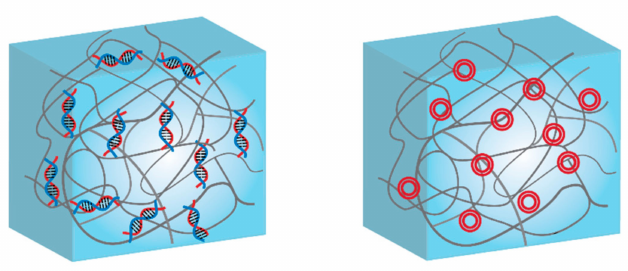
Scheme 3. Schematics of DNA-functionalized hybrid hydrogels: (left) single-stranded DNA covalently attached to the polymer sca ff old, and (right) plasmids or long DNA sequences conjugated